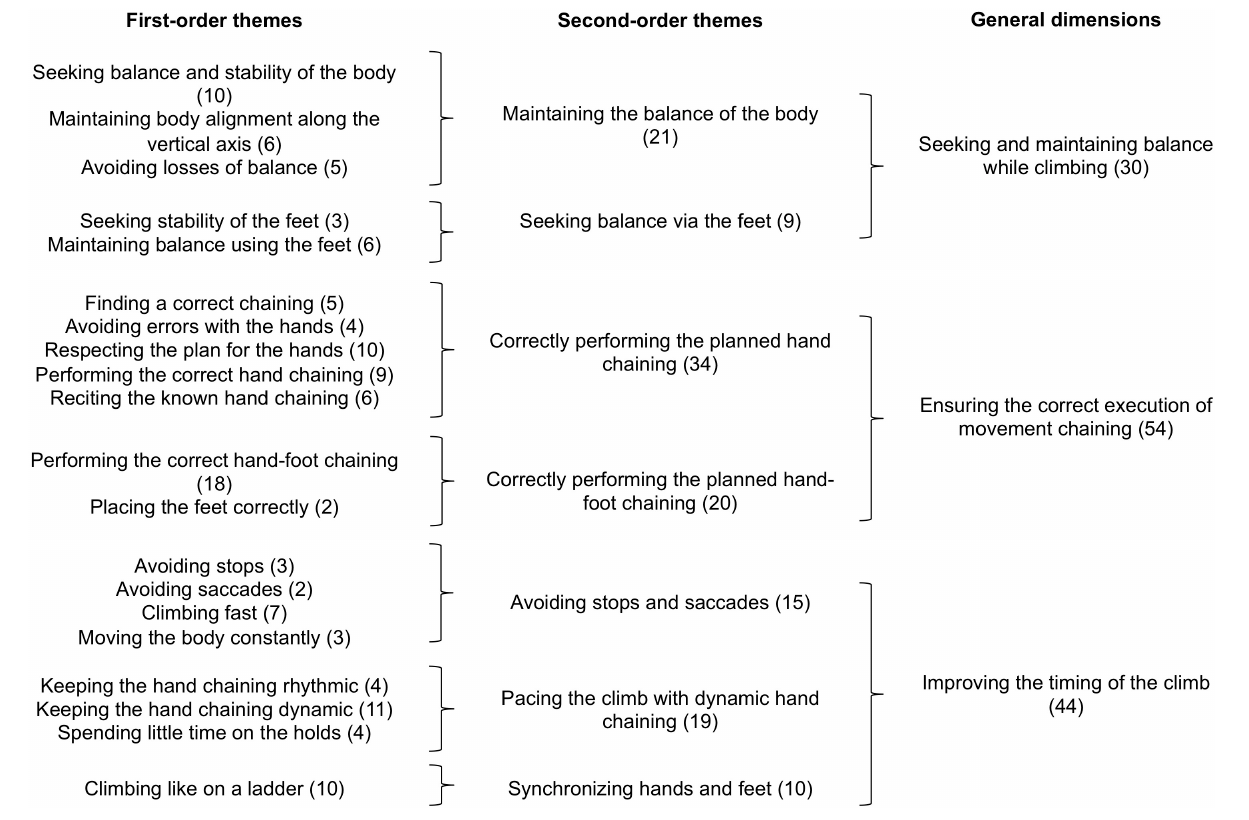
FIGURE 1 | Thematic analysis of the climber’s intentions. The first column presents the first-order themes. The second column presents the second-order themes (i.e., merging of the first-order themes). The third column presents the general dimensions (i.e., merging of the second-order themes). The numbers in parentheses associated with each theme refer to the number of occurrences identified from the